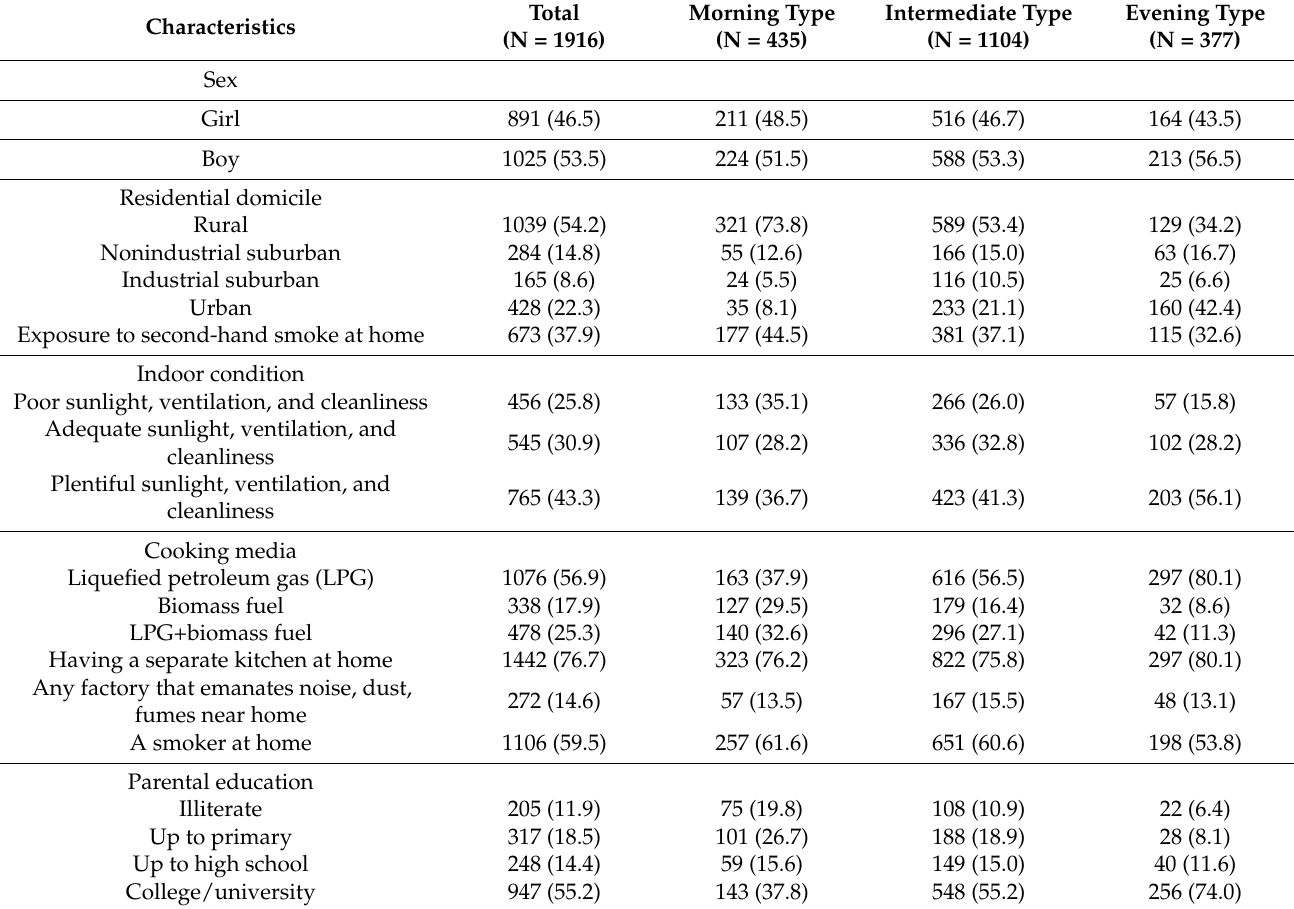
Table 1. Demographic profile of study participants according to